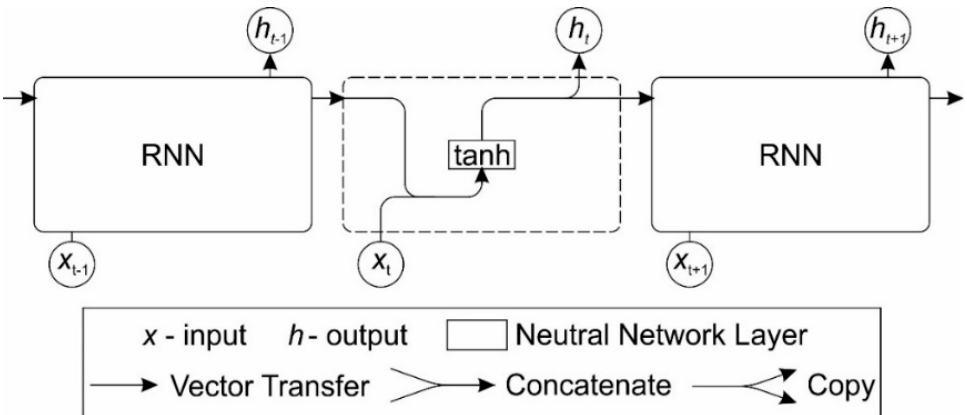
Figure 4. An unrolled Recurrent Neural Network.